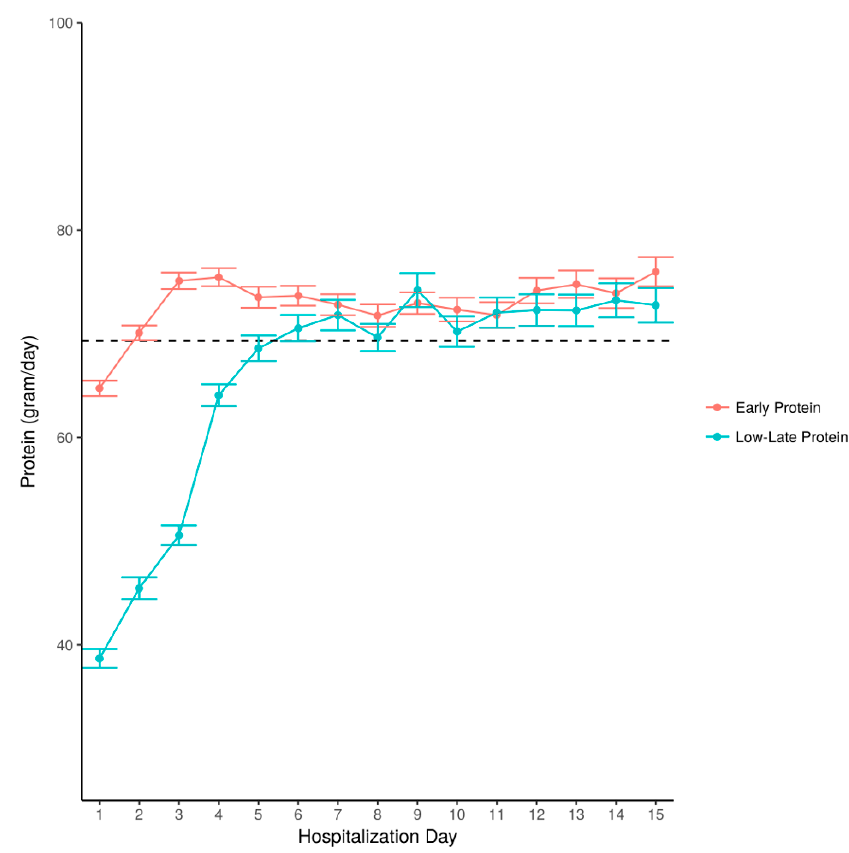
Figure 3. Amount of protein administered by hospitalization day—a comparison between the early protein and the late-low groups. Legend: The amount of daily protein, presented as grams per day, is shown according to hospitalization day. Stratification according to patient groups: those who received early protein and those who received late-low protein. Dotted line—mean amount for all patients throughout hospitalization.